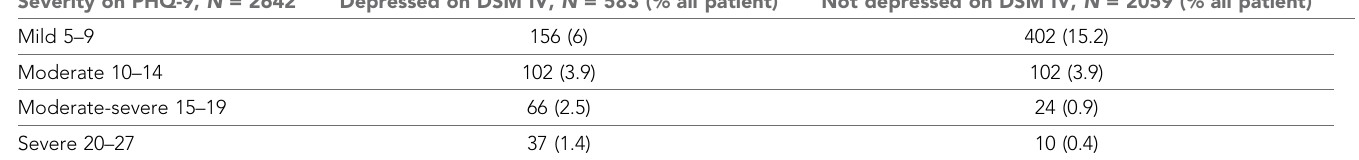
Table 2. Mismatch between PHQ-9 symptom questionnaire scores and psychiatric diagnoses. Severity on PHQ-9, N =